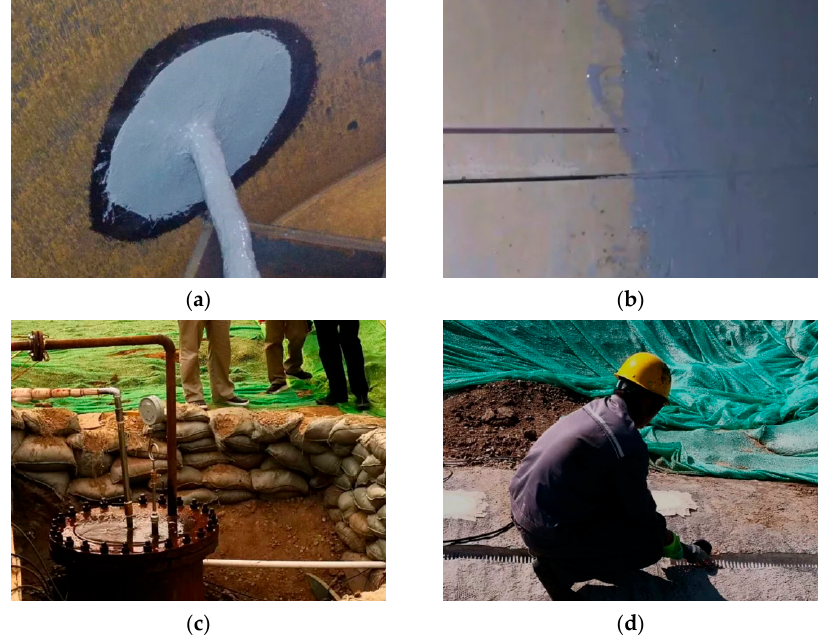
Figure 5. Test procedure: ( a ) inlet cable sealing, ( b ) cable distribution, ( c ) pressurization, ( d ) wire cutting.